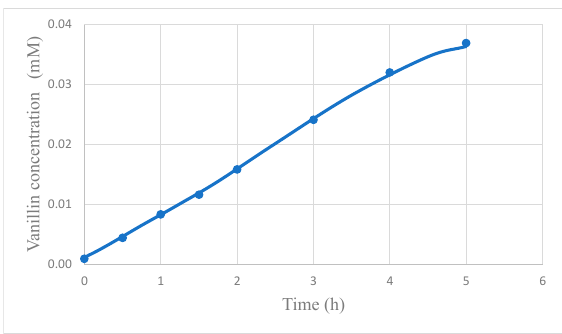
Figure 2. The concentration of vanillin in the reacting solution vs. time, t, in the case of photocatalysis without dialysis.